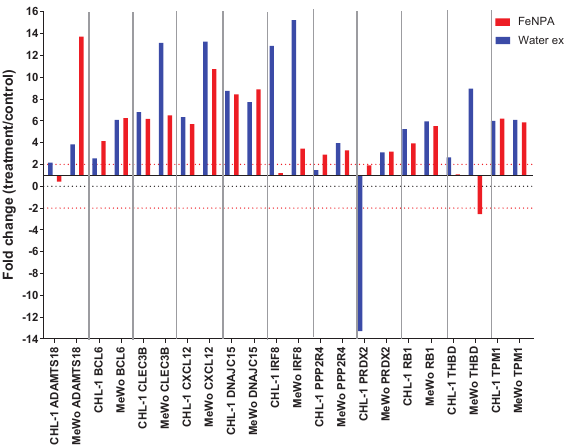
and ASP on gene expression in melanoma A